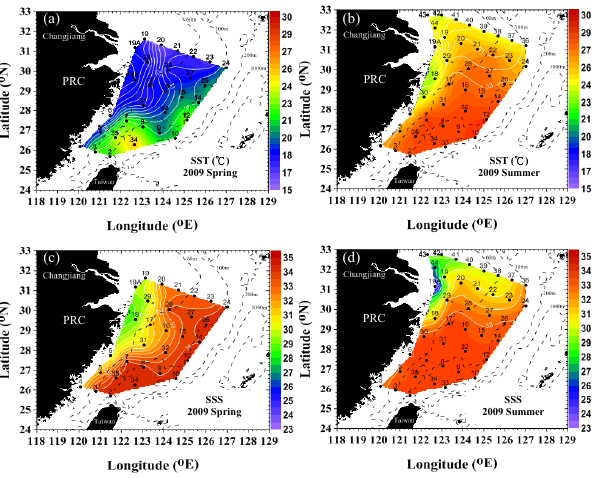
Fig. 2. Surface distributions of temperature (SST) are indicated in (a) and (b) ; and (c) and (d) indicate salinity (SSS) in spring ( a and c ) and summer ( b and d ) 2009 in the East China Sea.